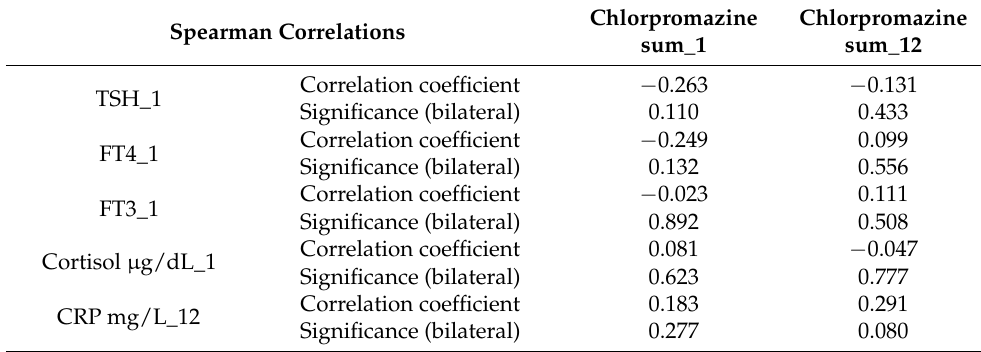
Table 10. Correlations between chlorpromazine equivalents and thyroid function markers. Chlorpromazine Chlorpromazine Spearman Correlations sum_1 sum_12 Correlation coefficient − 0.263 − 0.131 TSH_1 Significance (bilateral) 0.110 0.433 Correlation coefficient − 0.249 0.099 FT4_1 Significance (bilateral) 0.132 Correlation coefficient Correlation coefficient 0.081 Significance (bilateral) Correlation coefficient 0.183 0.291 Significance (bilateral) 0.277